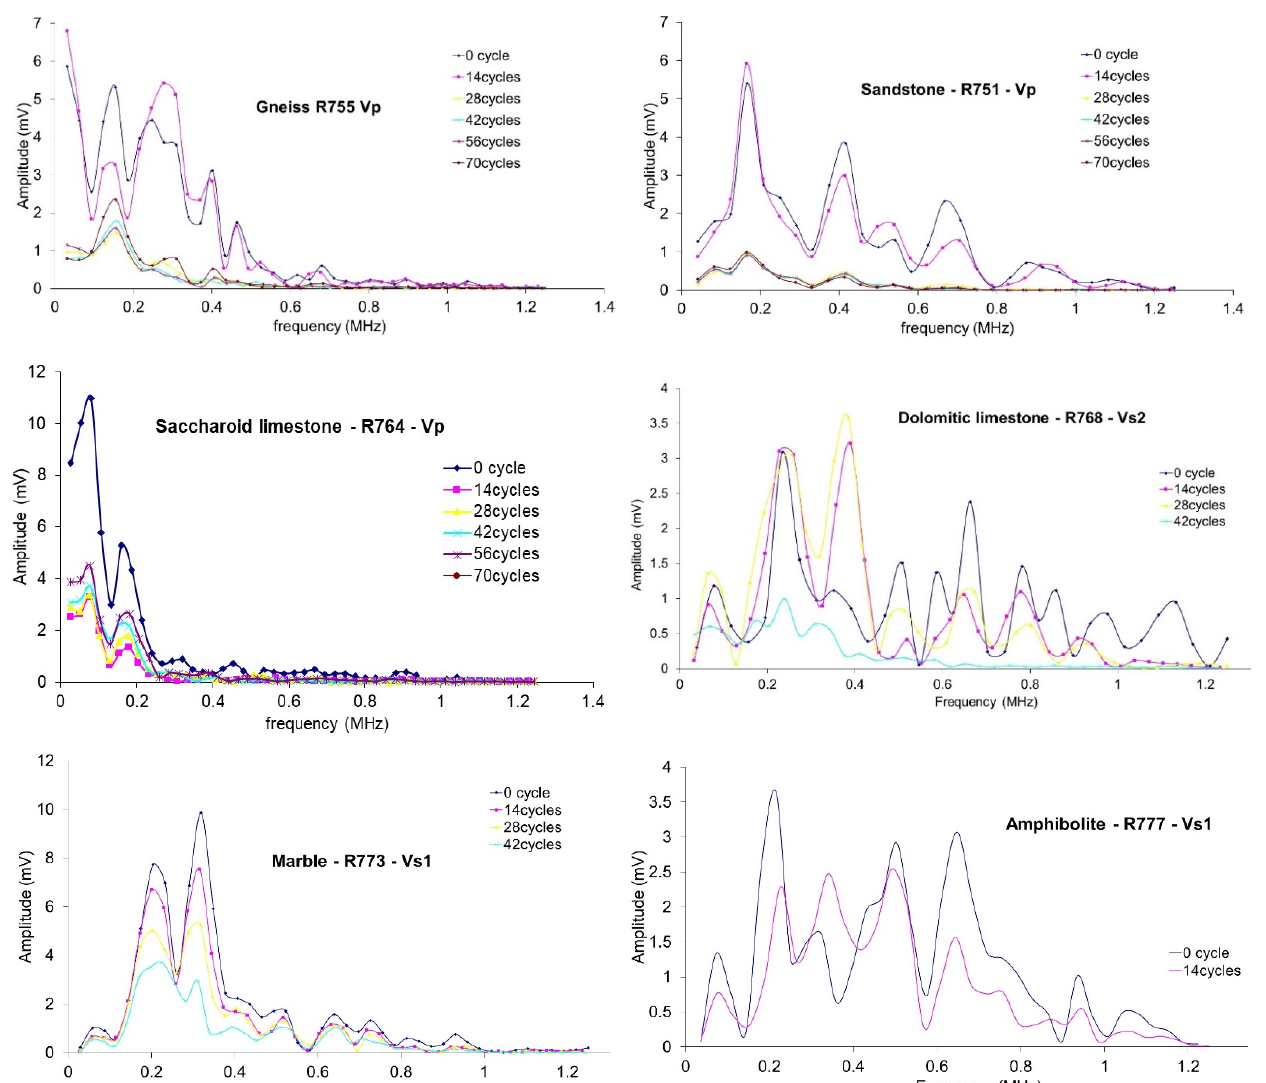
Figure 8. P-wave and S-wave frequency spectrum—a set of spectra (1 sample, only V p , Vs1 or Vs2) is given for each mineralogy). The rock type is mentioned in each graph.